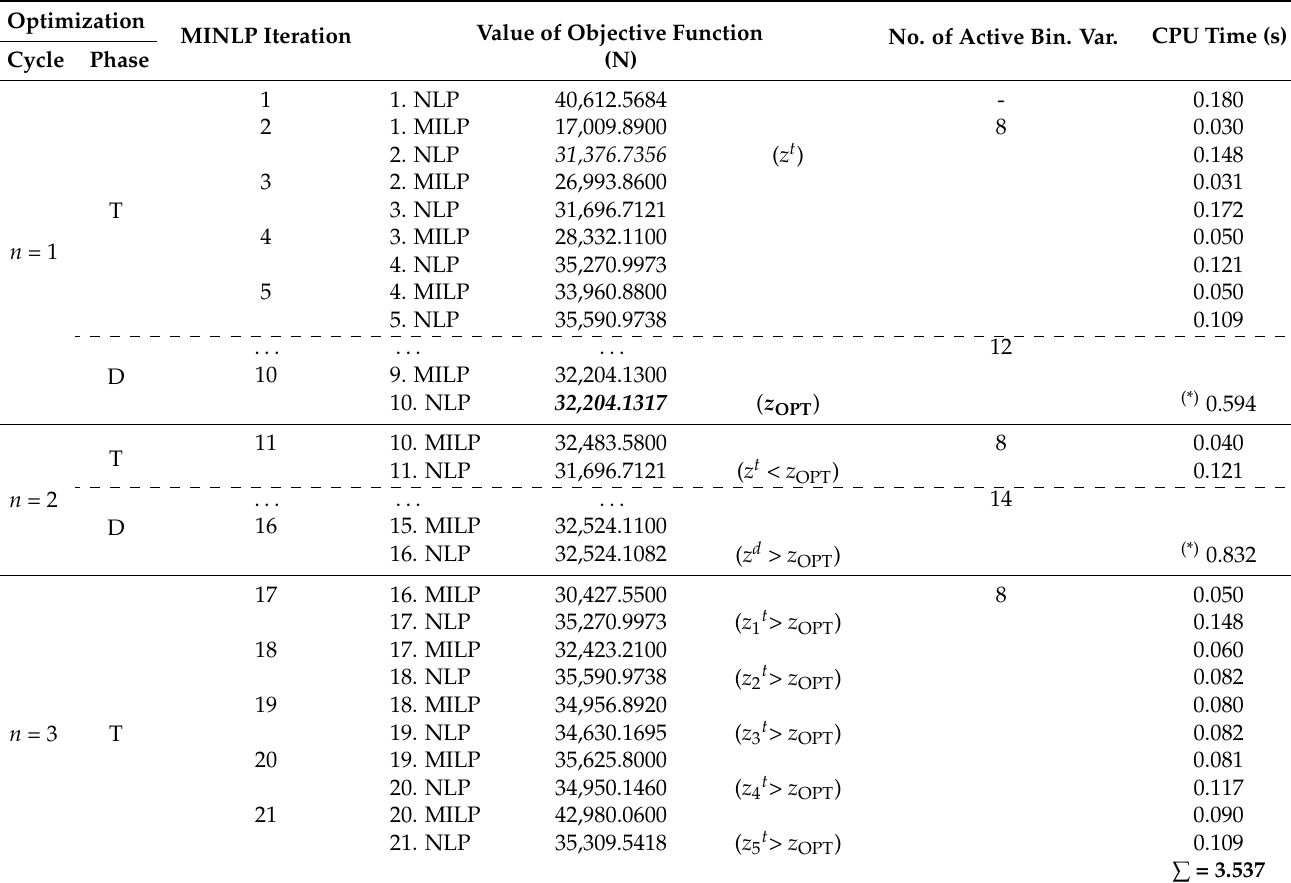
Table A1. Convergence of the Modified OA/ER algorithm and the MTP strategy, example TC10c (topology optimization, with buckling constraints).